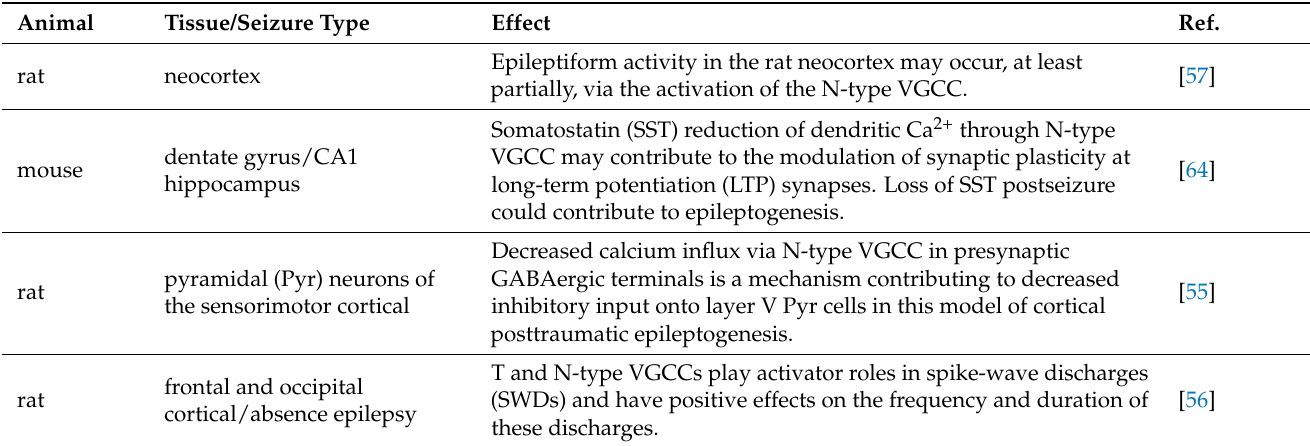
Table 5. Contribution of different animal models to clarify the association of N-type VGCC with